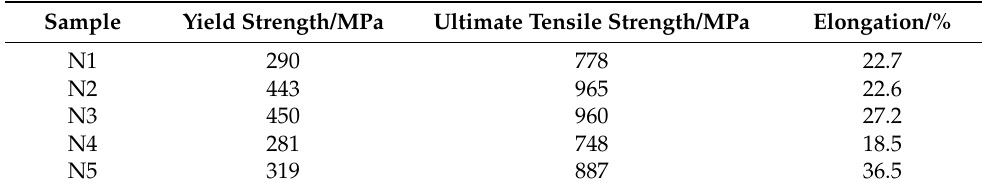
Figure 6. Tensile stress–strain curves of the laminated composites at room temperature for: ( a ) N1, N2, and N3; ( b ) N4, N5, and N2. Table 3. Tensile properties of the laminated composites at room